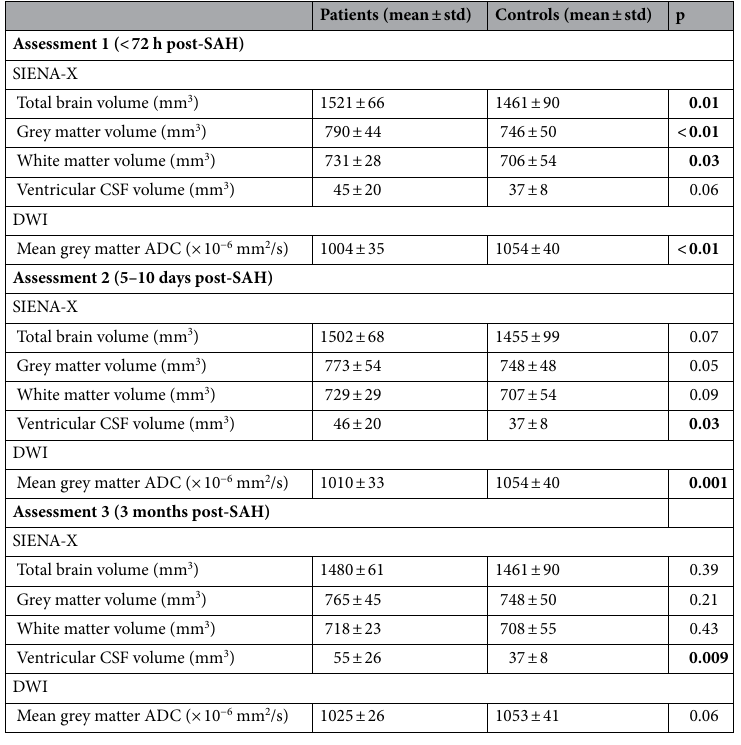
Table.2. Global MRI brain measures at each assessment (volumetric: SIENA-X and water diffusion: diffusion- weighted imaging—DWI). Significant values are in